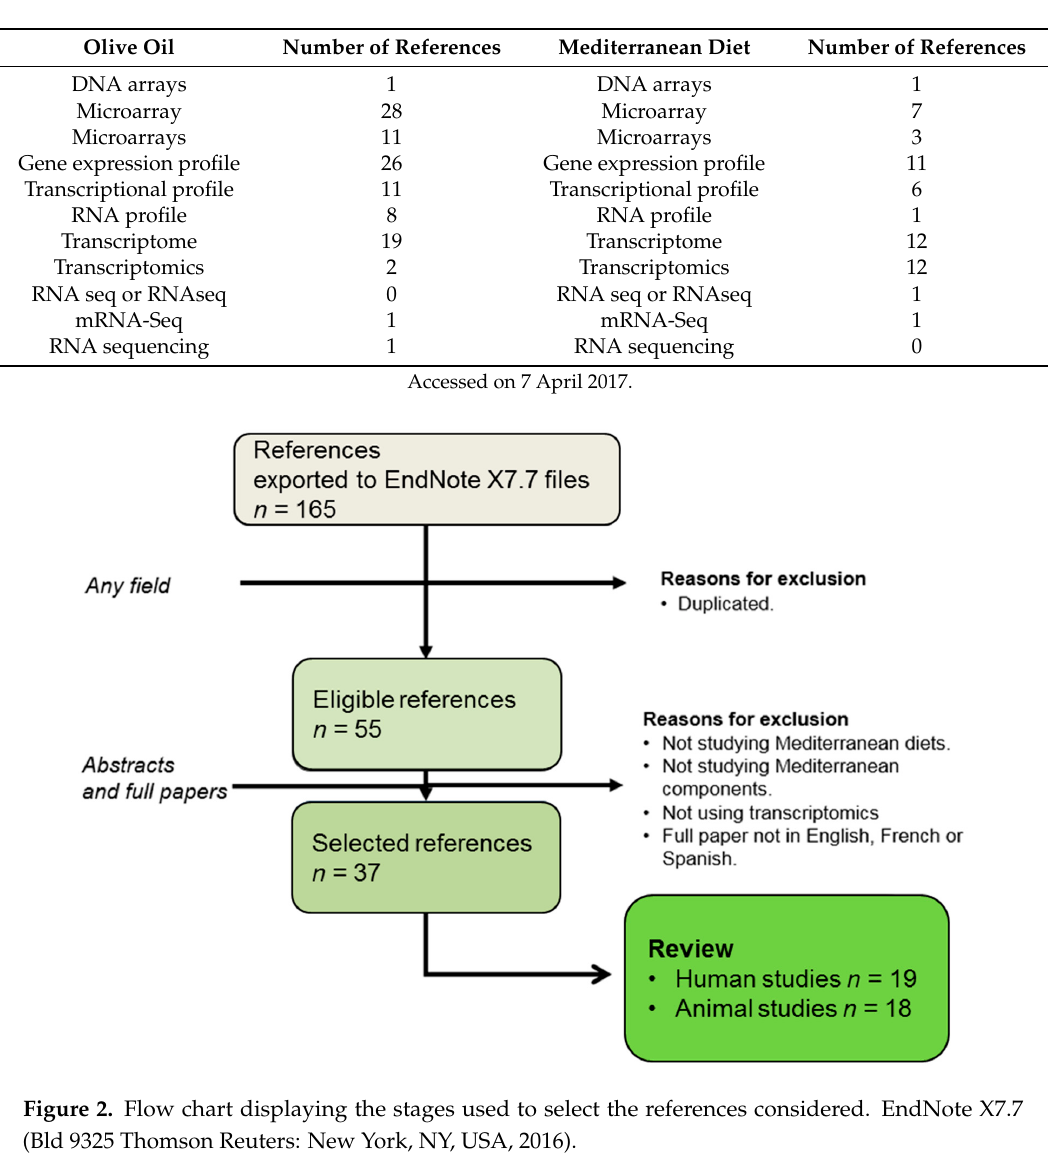
Table 1. Combinations of keywords used to search the PubMed database.